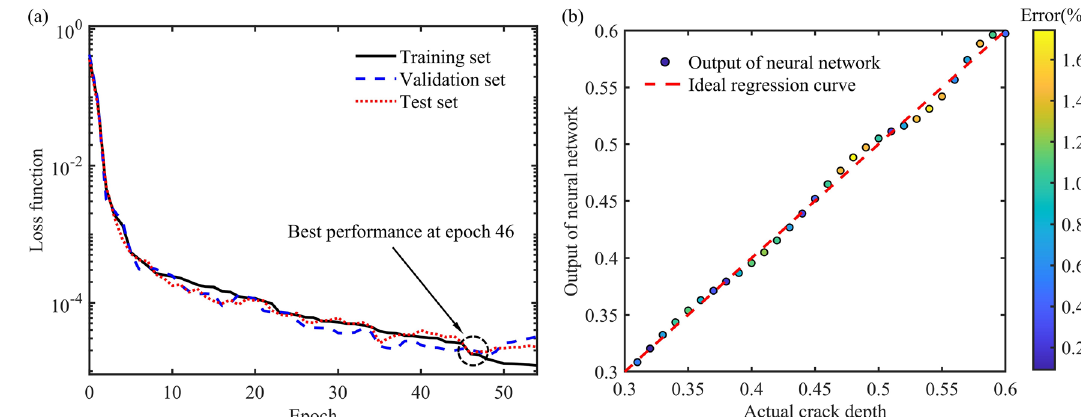
Figure 12 Training and test results of the RBF network when the crack is located in the middle of the rotor system: ( a ) Loss function curve, ( b ) Regression output